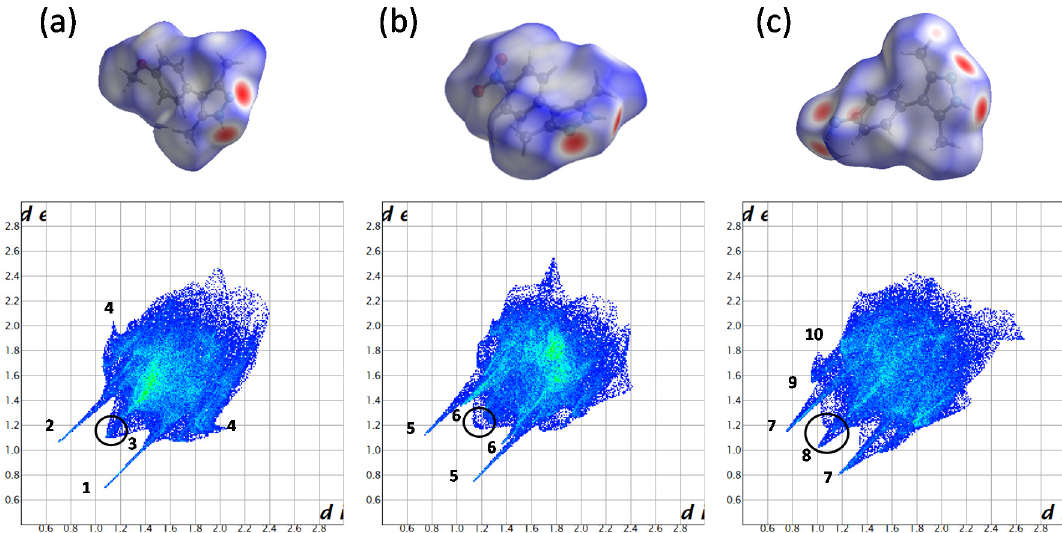
Figure 7. Hirshfeld surfaces mapped over the d norm and 2D fingerprint plots for ( a ) P1•CH 3 OH , ( b ) P2 , and ( c ) P3.